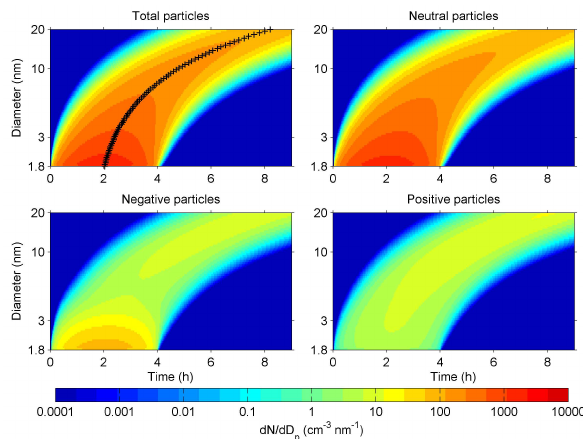
Fig. 3. The time evolution of the particle number size distribu- tion from the example simulation described in Sect. 4.2. The black crosses mark the centre of the